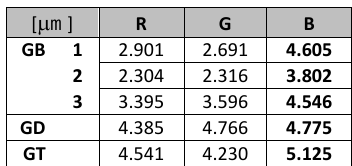
Table 7. Comparison of the principal distance for the individual calibrations of all assessed cameras (1st repeat). All units in mm. The largest principal distance values are highlighted.